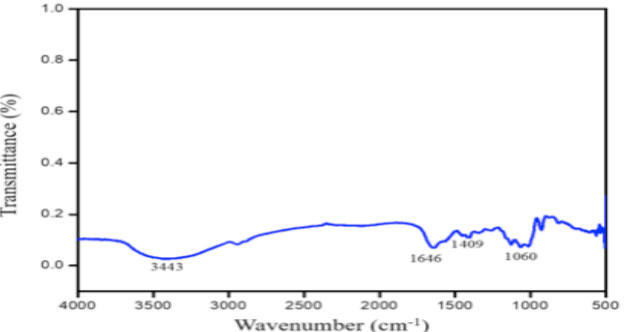
Figure 7. FTIR absorption spectrum of γ -PGA produced from selective fermentation by B. safensis subsp. safensis PY1-19 from peruñyaan.